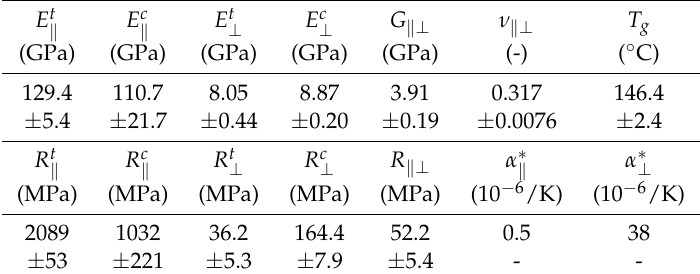
Table 1. Elastic, strength and thermal properties of T700SC/LY556 composite material